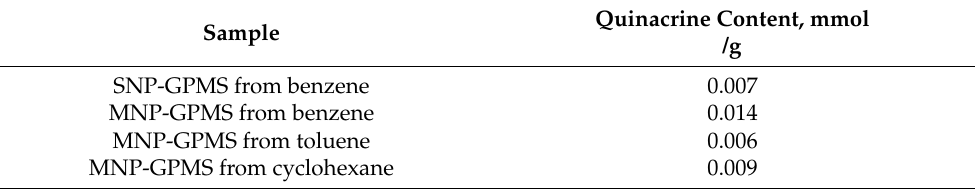
Table 2. Quinacrine content immobilized on a spacer obtained from different